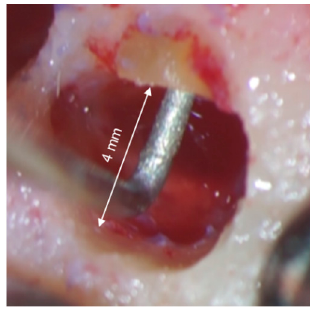
Figure 11. Bone crypt (4 mm in diameter) after osteotomy, allowing an ultrasonic tip to move without interference.